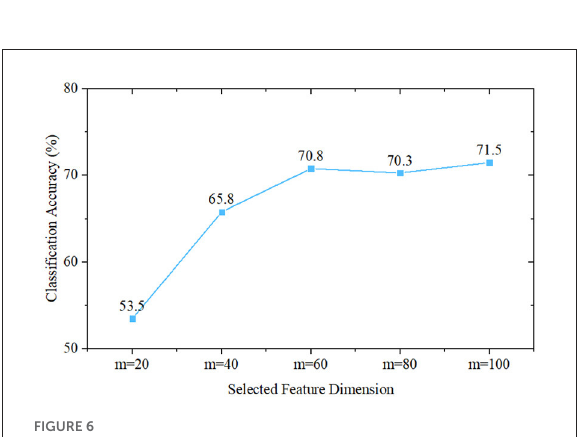
FIGURE6 Classification performance of Naive Bayes